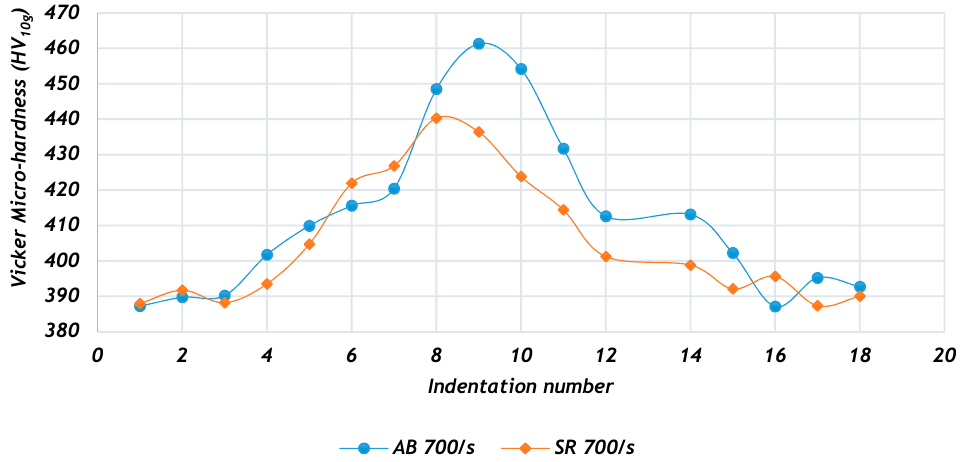
Figure 10. Variation in the microhardness of a typical section of the ASB at a small load of 10 g.